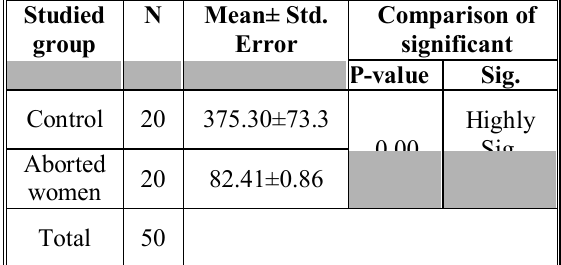
Table (2): The mean value of concentration (pg/ml) of IL-6 among studied group.